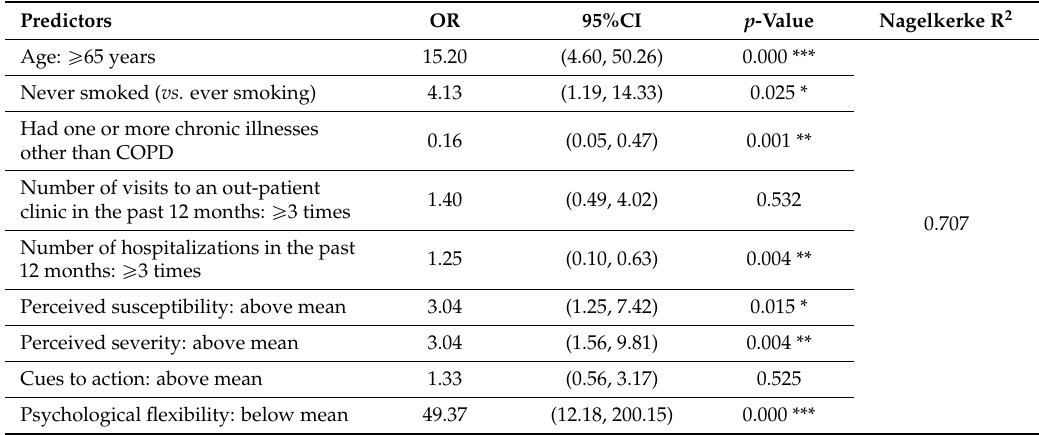
Table 3. Predictors of influenza vaccination among people with